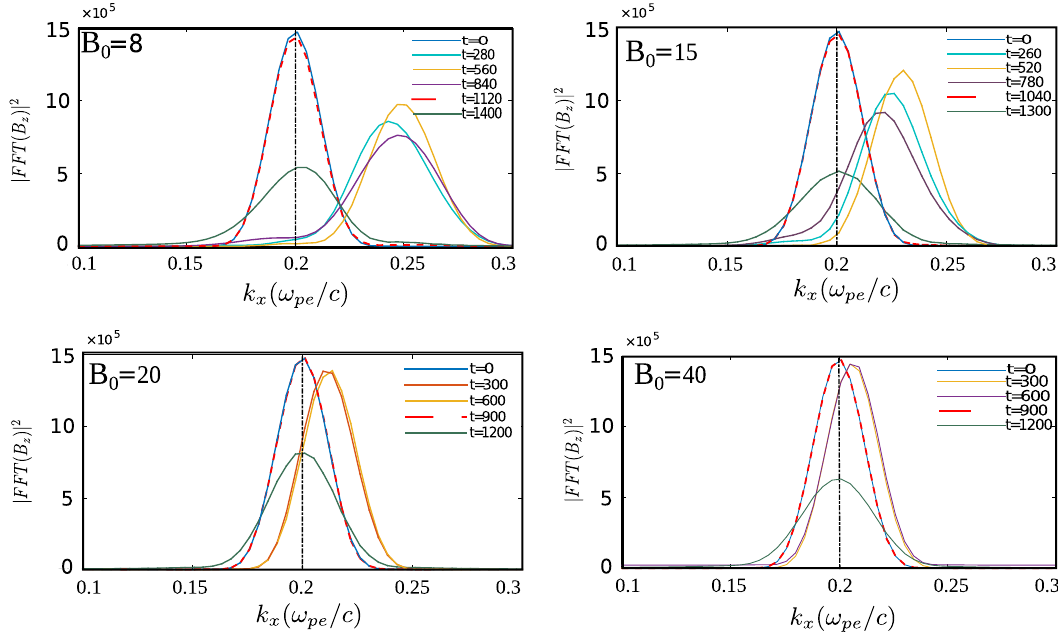
Figure 8. FFT of B z with x at different times showing that as laser interacts with plasma, k x shifts to a larger value than the initial k x . This shift reduces as we increase the magnitude of applied magnetic field (shown in different subplots). This shift in k x is also reflected in velocity of EM wave approaching c in the medium (Table 4) and the transmission coefficient approaching unity (Table 3).